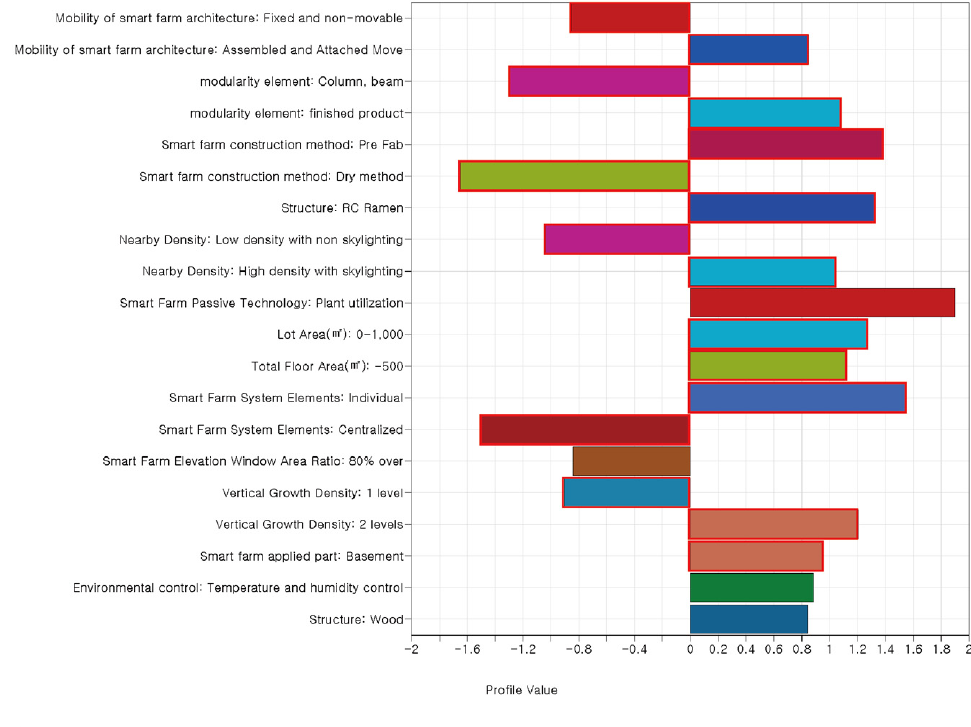
Figure A2. C2. Figure A2. C2.